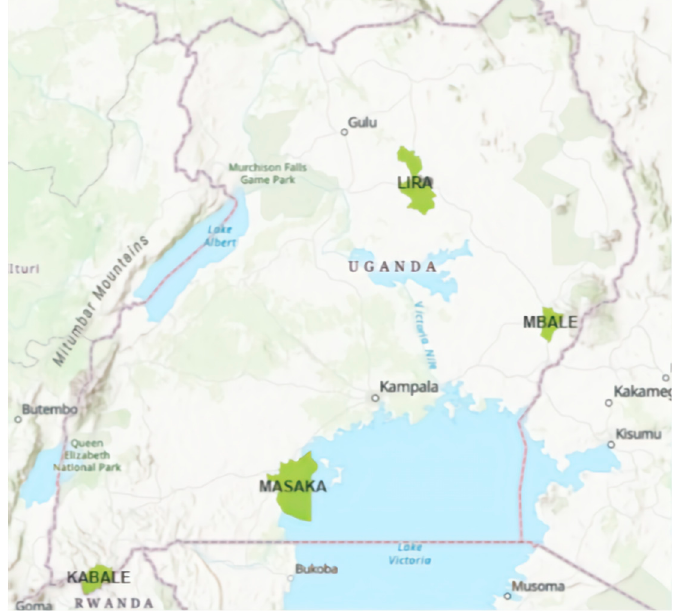
Figure 1. Map of the study sites (1:10,000,000 scale). The map was created using ArcGIS and data from the World Resource Institute (https://www.wri.org/resources/data-sets/uganda-gis-data).